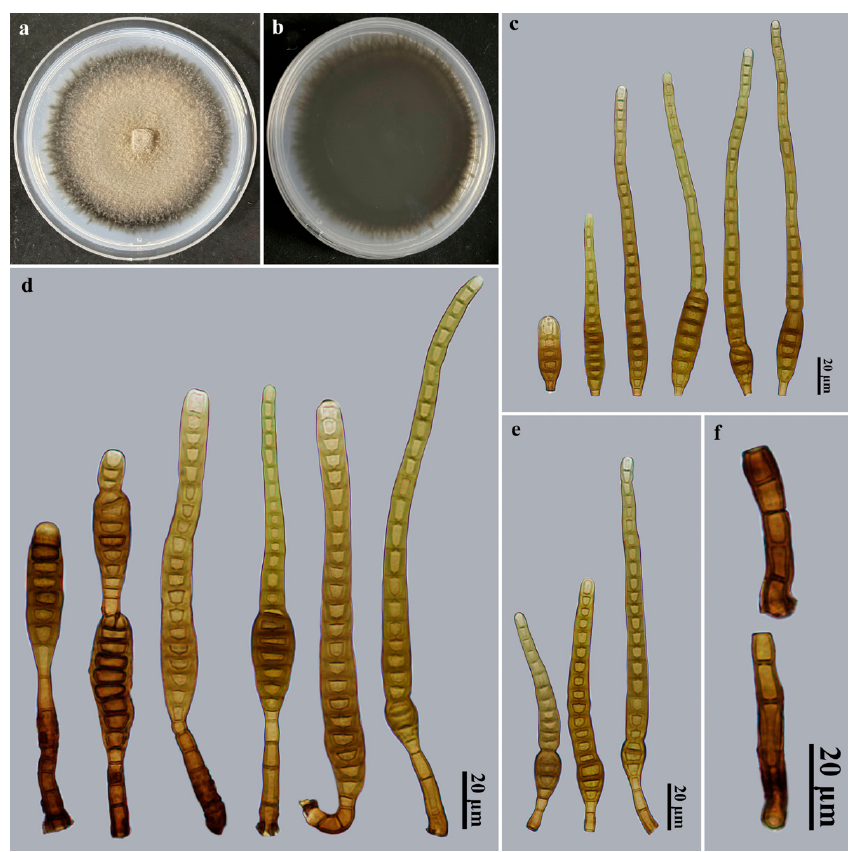
Figure 2. Distoseptispora mengsongensis (HJAUP M2126, holotype). ( a ) Surface of colony after 2 weeks on PDA; ( b ) reverse of colony after 2 weeks on PDA; ( c ) Conidia; ( d , e ) Conidiophores, co- nidiogenous cells, and conidia; ( f ) Conidiophores. Material examined: China, Yunnan Province, Xishuangbanna Dai Autonomous Prefecture, Menghai County, Mengsong Township, on dead branches of an unidentified broadleaf tree, 12 July 2021, J.W. Liu, HJAUP M2126 ( holotype ), ex-type culture perma- nently preserved in a metabolically inactive state, HJAUP C2126. Notes: Phylogenetic analyses showed that D. mengsongensis (HJAUP C2126) clusters with D . fasciculata (KUMCC 19-0081). BLASTn analysis of D . mengsongensis (HJAUP C2126) and D . fasciculata (KUMCC 19-0081) showed 99% identity (544/551, no gaps) using ITS, 99% identity (565/567, two gaps) using LSU, and 100% identity (927/927, no gaps)